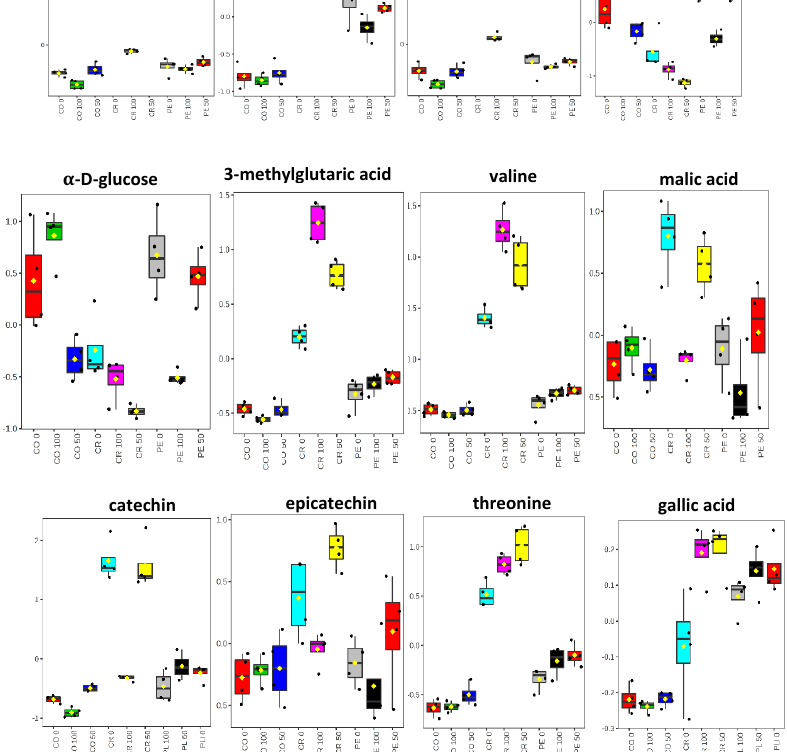
Figure 6. Boxplots of tentatively identified metabolites showing their relative quantification associated with MD2 pineapple waste extracts using 1H NMR spectra binned data. The metabolites are those with variable importance in the projection (VIP) value > 0.7 of MD2 pineapple extracted with 0, 50 and 100% ethanol ratio Waste extracts are prepared from CO = core; CR = crown and PL = peel. By relating the quantification data with the PLS biplot (Figure 4) and correlogram plot (Figure 5), these variation in metabolites 3- methylglutaric acid (31), α -linolenic acid (16), valine (10), and threonine (8) in crown extracts from a 100% ethanol ratio may provide an explanation for the higher